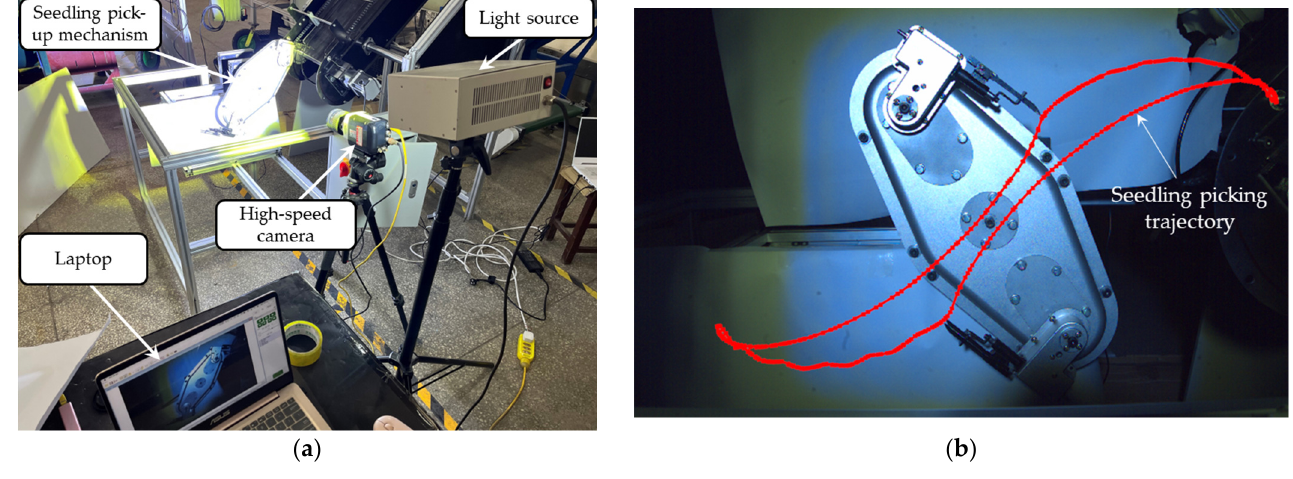
Figure 12. Idle test: ( a ) Idle test device; ( b ) Test trajectory.